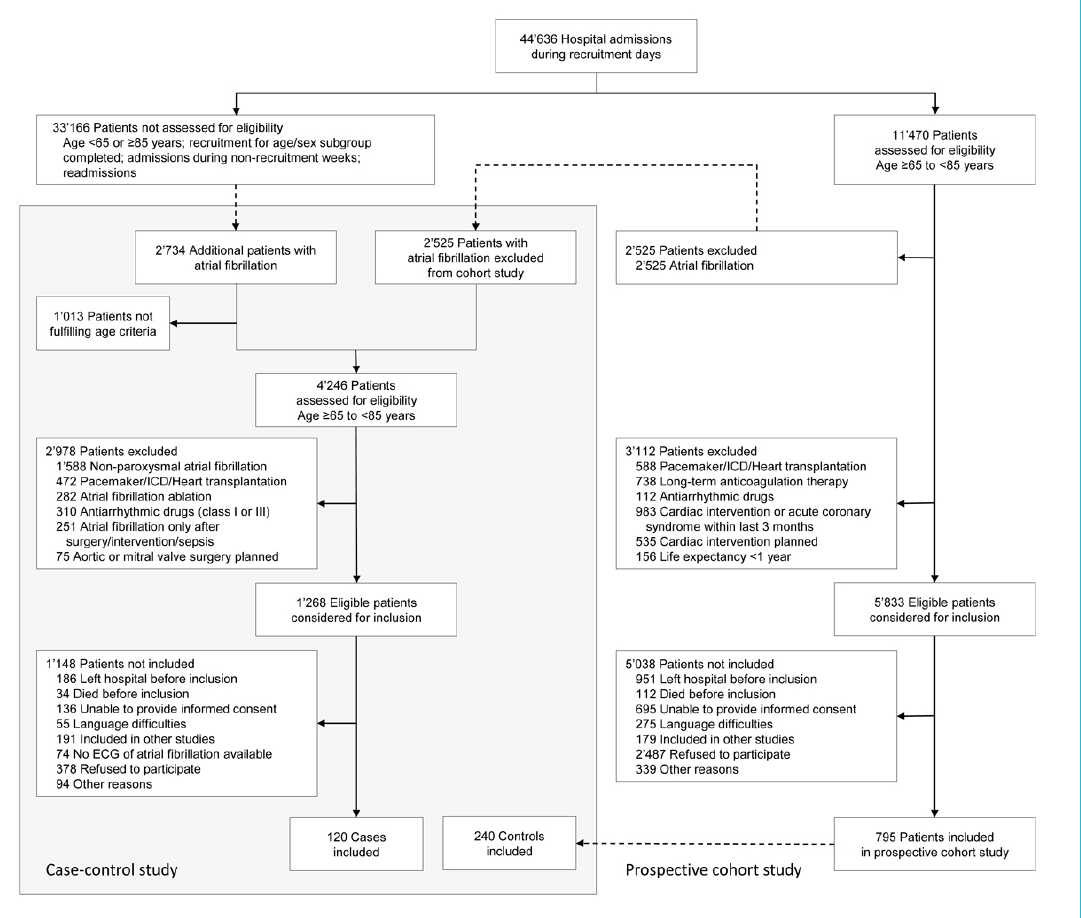
Figure 1: Flow chart showing recruitment of participants for the cohort study and for the case-control study (grey shaded area).